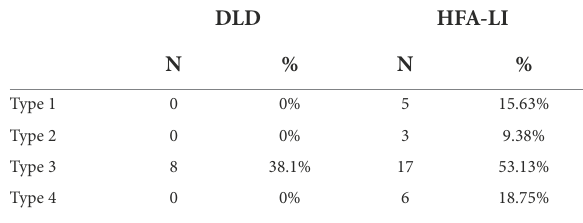
TABLE 7 Number (N) and percentage (%) of children in stereotyped